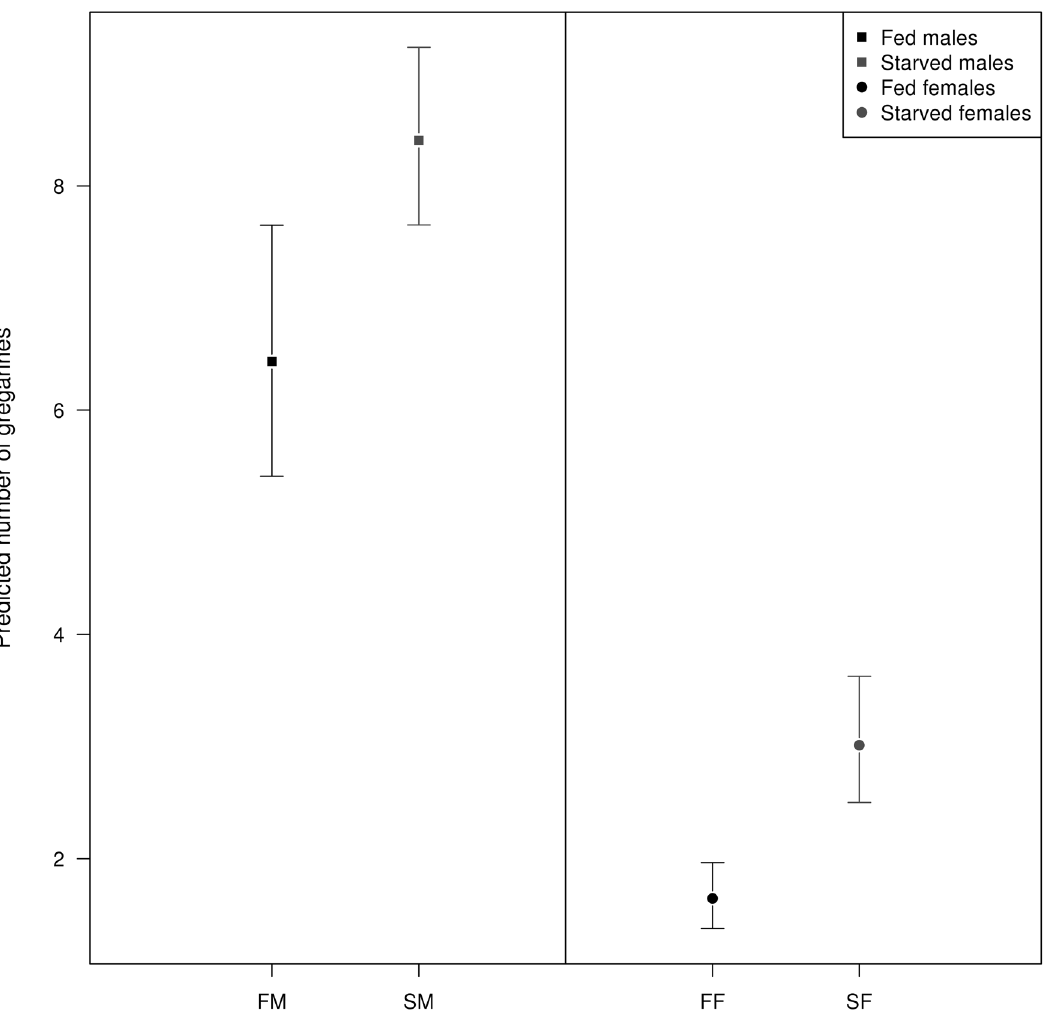
Figure 7. Parasite infection after food stress in both sexes. Predicted gregarine abundance according to sex and food treatment interaction. Error bars show 95% confidence